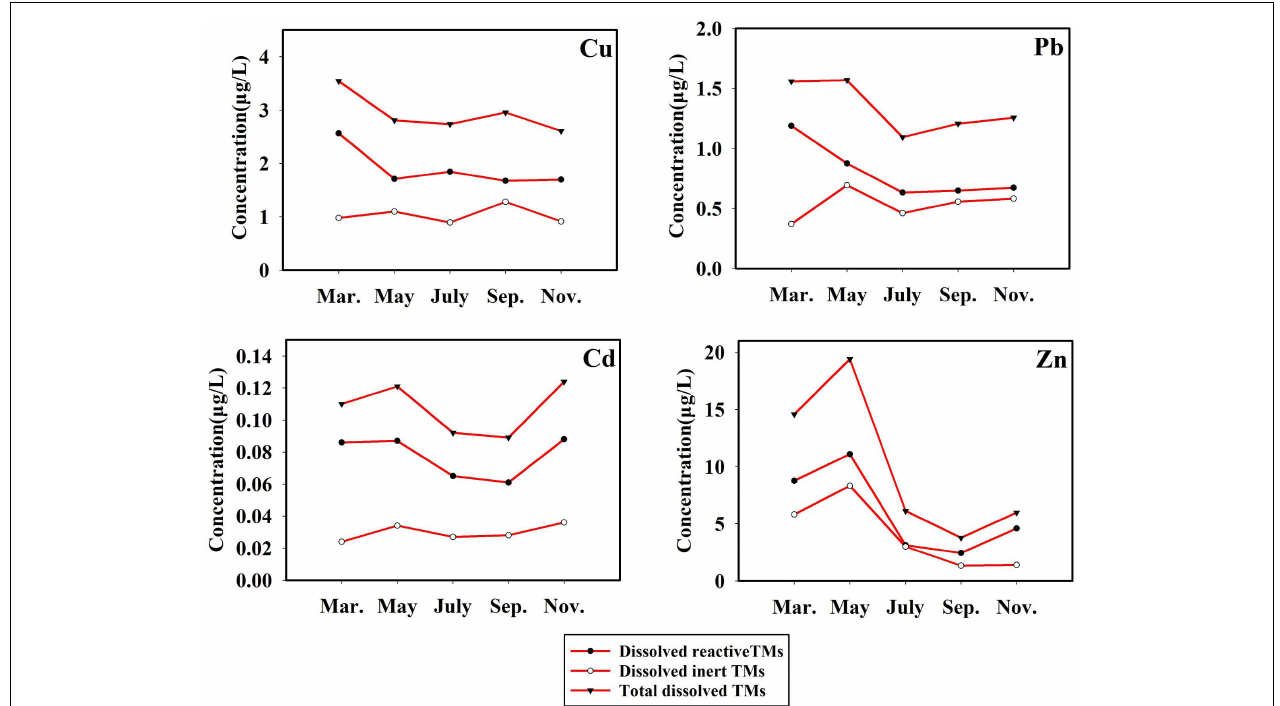
FIGURE 6 | Temporal variation of different species of Cu, Pb, Cd, and Zn ( µ g/L, monthly average values) in the surface seawater of Sishili Bay.